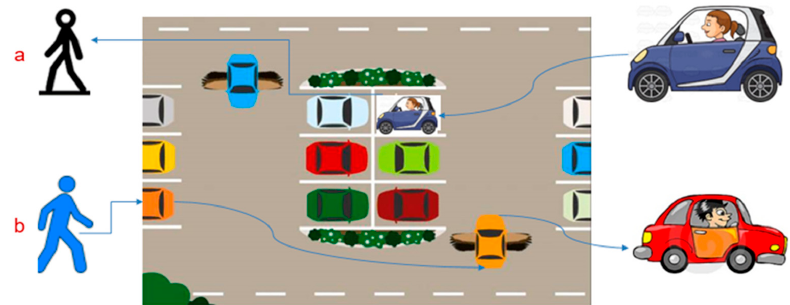
Figure 3. The theoretical idea of the proposed system. Parking and unparking examples are shown in ( a ) and ( b ) respectively.